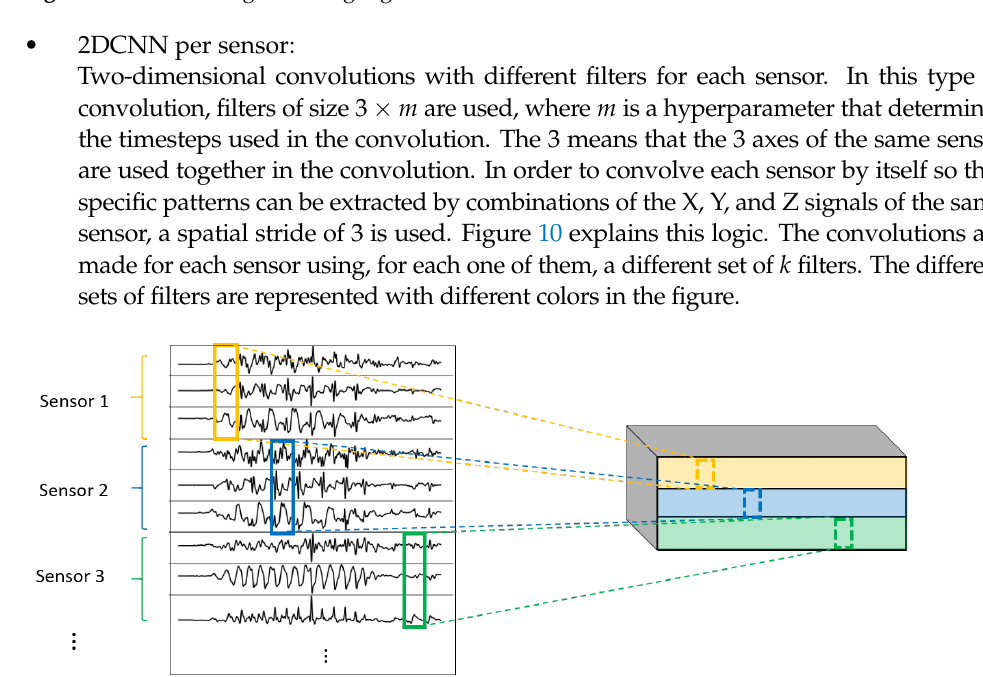
Figure 9. 2DCNN weight sharing logic.